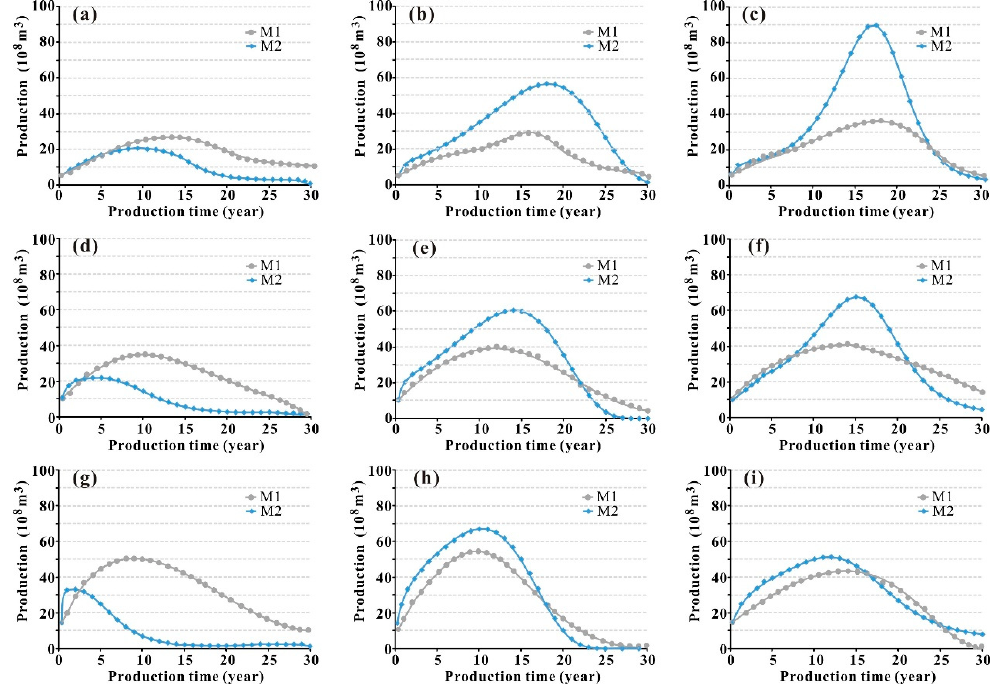
Figure 5. Gas supply by two different methods under different IP and price scenarios. ( a ) IP1-P1; ( b ) IP1-P2; ( c ) IP1-P3; ( d ) IP2-P1; ( e ) IP2-P2; ( f ) IP2-P3; ( g ) IP3-P1; ( h ) IP3-P2; ( i ) IP3-P3.